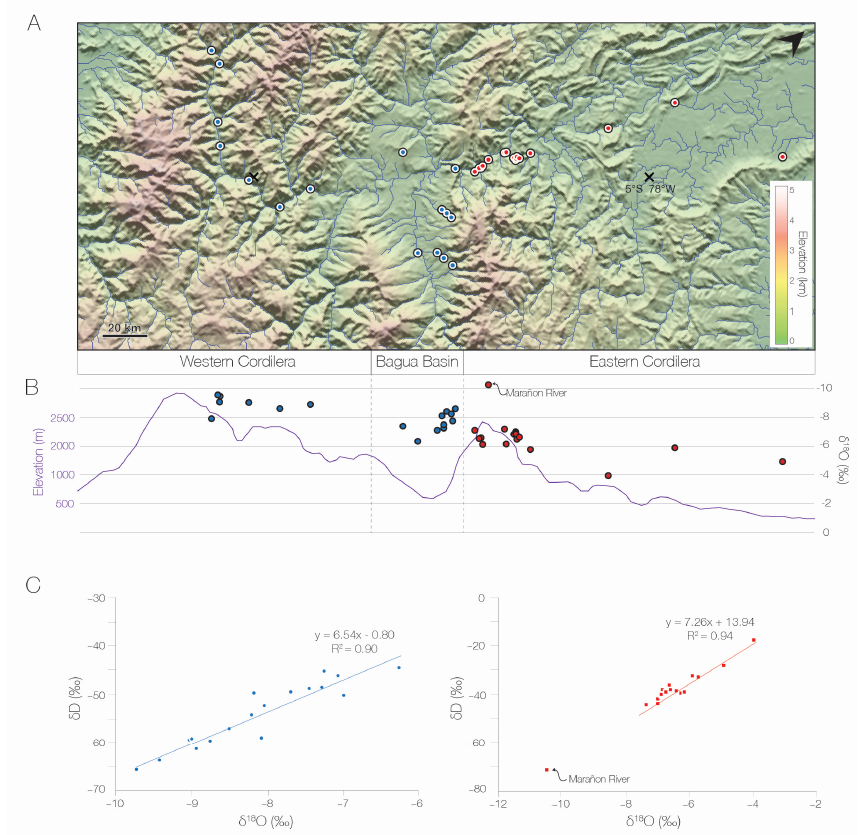
Figure 6. ( A ) Digital elevation model of the Bagua Basin and neighboring Western and Eastern cordilleras showing the location of meteoric water samples (blue and red dots). ( B ) Swath topographic profile across the area depicted in panel A, showing the δ 18 O values for the meteoric water samples analyzed along with their location along the transect. ( C ) Meteoric water lines plotted for the mete- oric water samples from the eastern slope of the Eastern Cordillera and Subandean zone (red) and from the Bagua Basin and eastern slope of the Western Cordillera (blue). One sample collected from the Marañon River (labeled on figure) is not considered in the meteoric water line slope calculation. Oxygen isotopic composition of meteoric water reconstructed from pedogenic car- bonates collected from paleosols of the Campanian Fundo El Triunfo Formation suggest that these paleosols were formed in an environment relatively proximal to the source of moisture where the water vapor had not experienced significant 18 O depletion prior to precipitation. The δ 18 O mw values reconstructed from pedogenic carbonates collected from